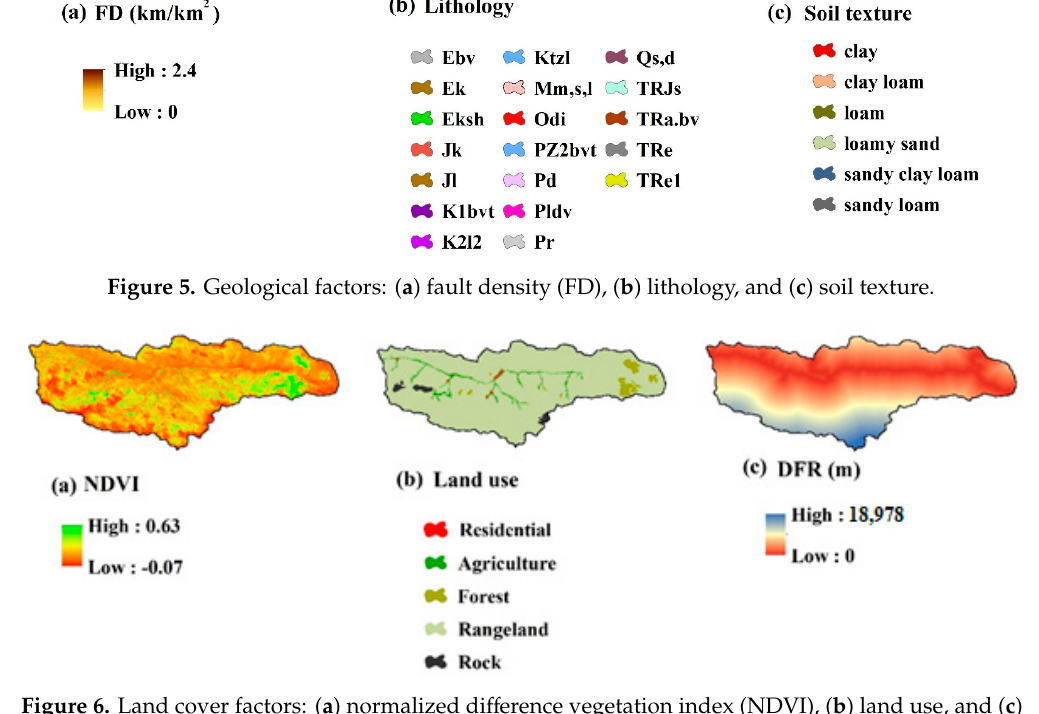
Figure 6. Land cover factors: ( a ) normalized difference vegetation index (NDVI), ( b ) land use, and ( c ) distance from road (DFR).